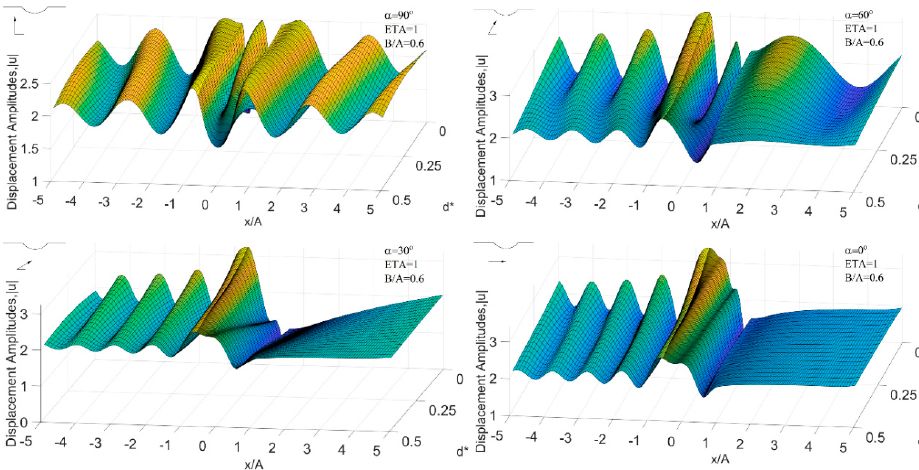
α= ° ° ° = when 0 , 30 , 60 , and = 0 α= ° 30 ° 60 ° when , , , and